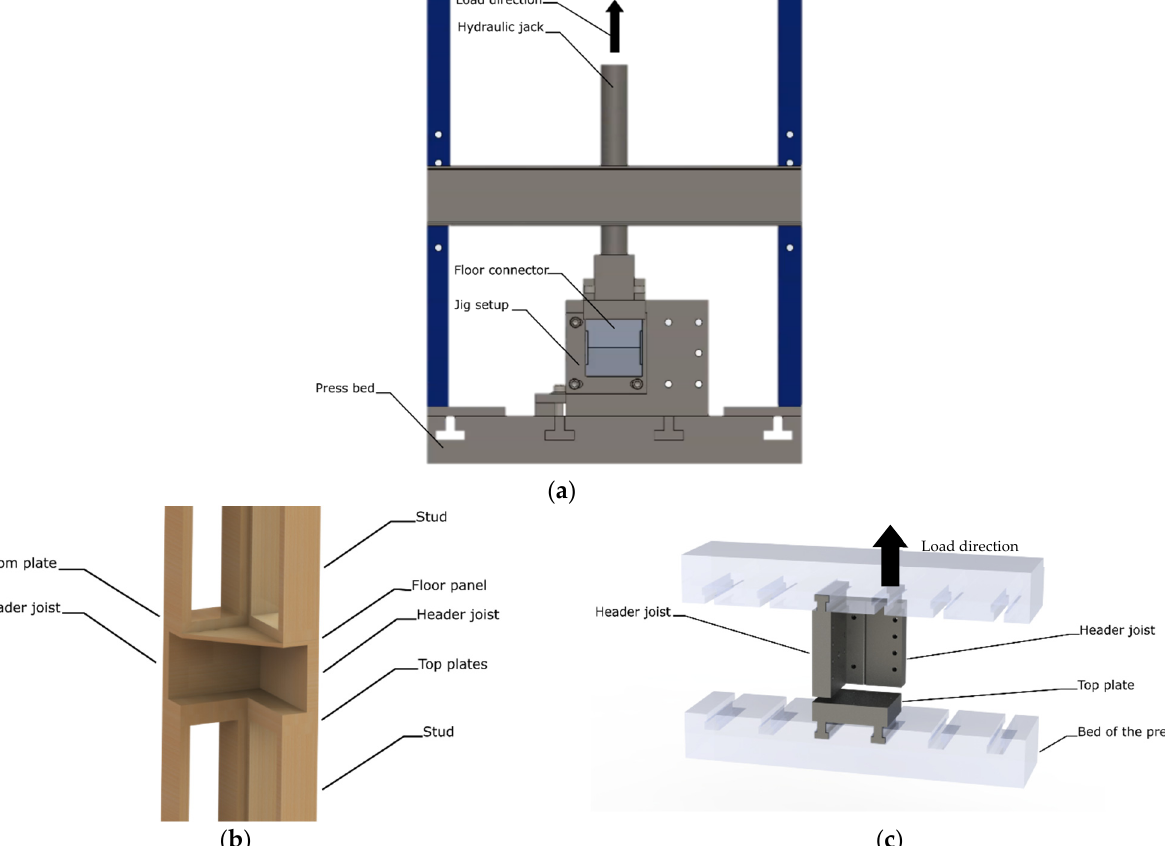
Figure 2. ( a ) 3D model of the jig mounted on the 10 ton hydraulic press for shear testing, ( b ) 3D model of a typical corner showing where the connector is located in the light-framed wood modules, ( c ) 3D model of the jig mounted on the 230 ton hydraulic press.